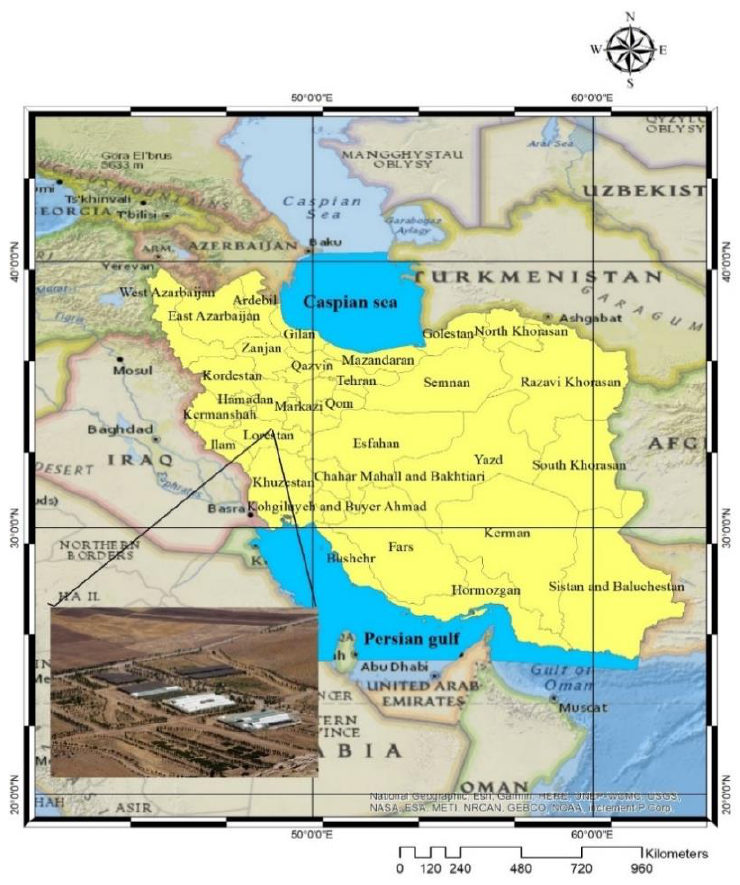
Figure 1. Geographical location of the studied